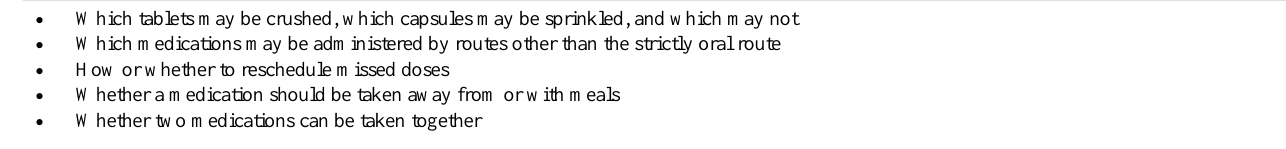
Table 4. Desirable encoding of machine-actionable dosing